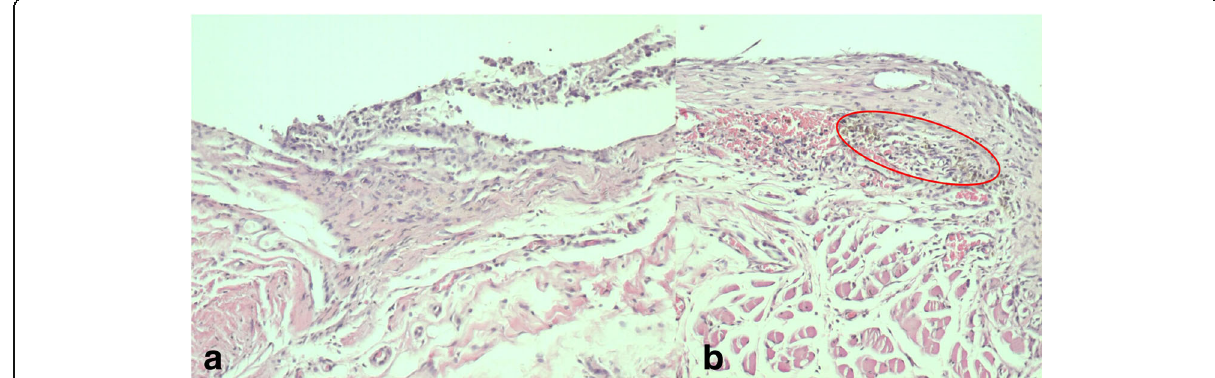
Fig. 5 a The sample of the control group at day 14. b The sample of the study group at day 14 , brown-black granules ( encircled ) (H&E; a , b ×200)